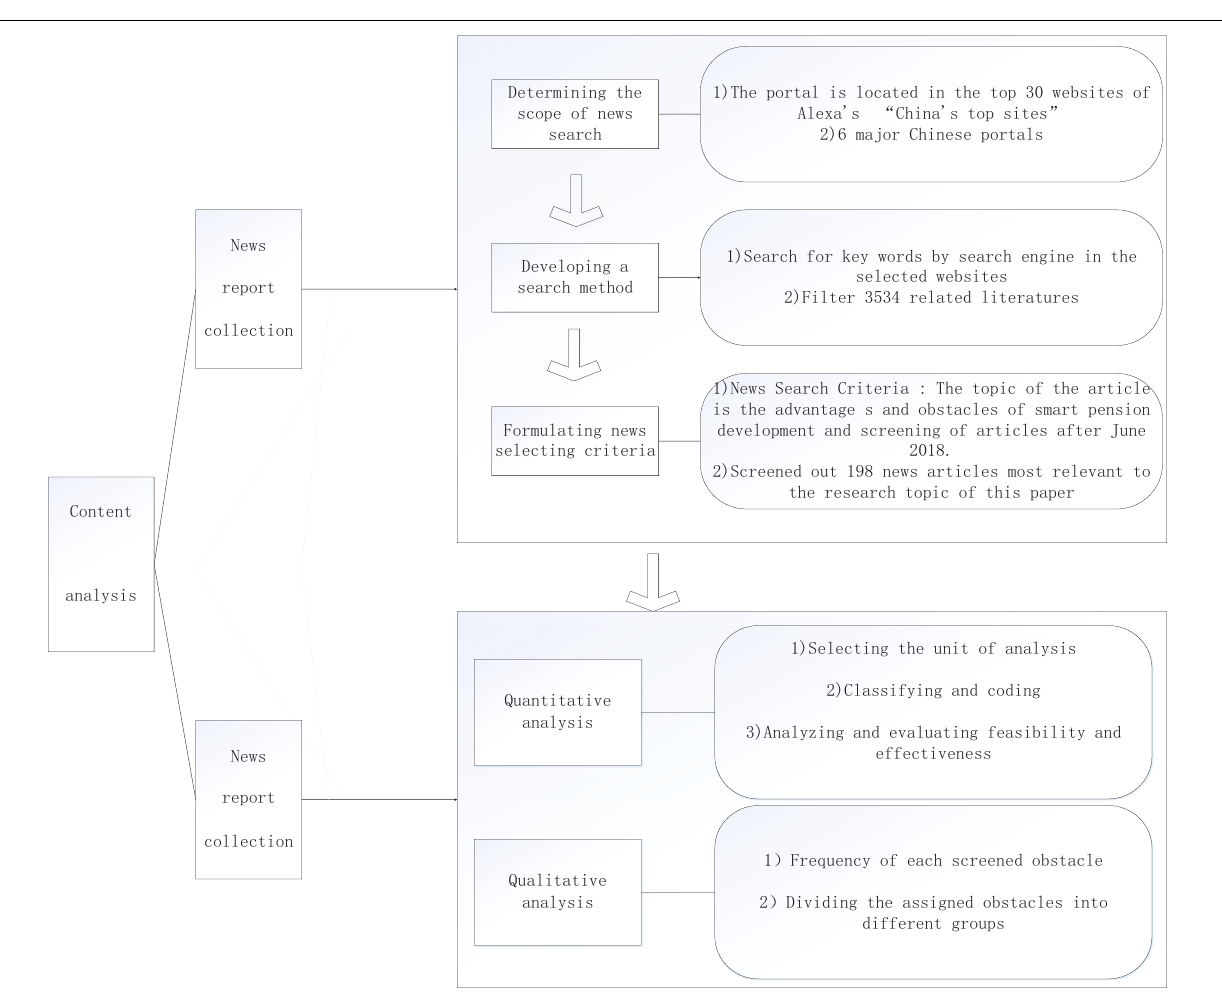
FIGURE 1 | Content analysis process